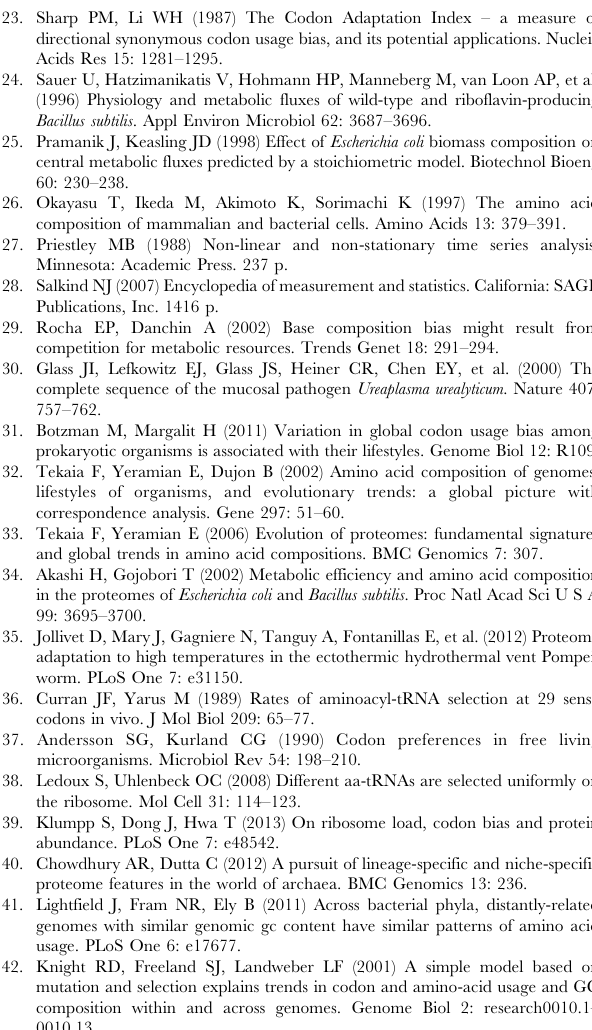
Figure S1 Principal Component Analysis of organisms as a function of cRAAA considering A) all predicted protein sequences in the genome [as shown in Figure 2A] and B) only ribosomal proteins and RNA polymerases. Table S1 Relative amino acid composition of different environments, as reported in and calculated from the literature. Table S2 Relative amino acid composition of different organisms calculated in this study based on predicted protein sequences of fully sequenced organisms (faa: